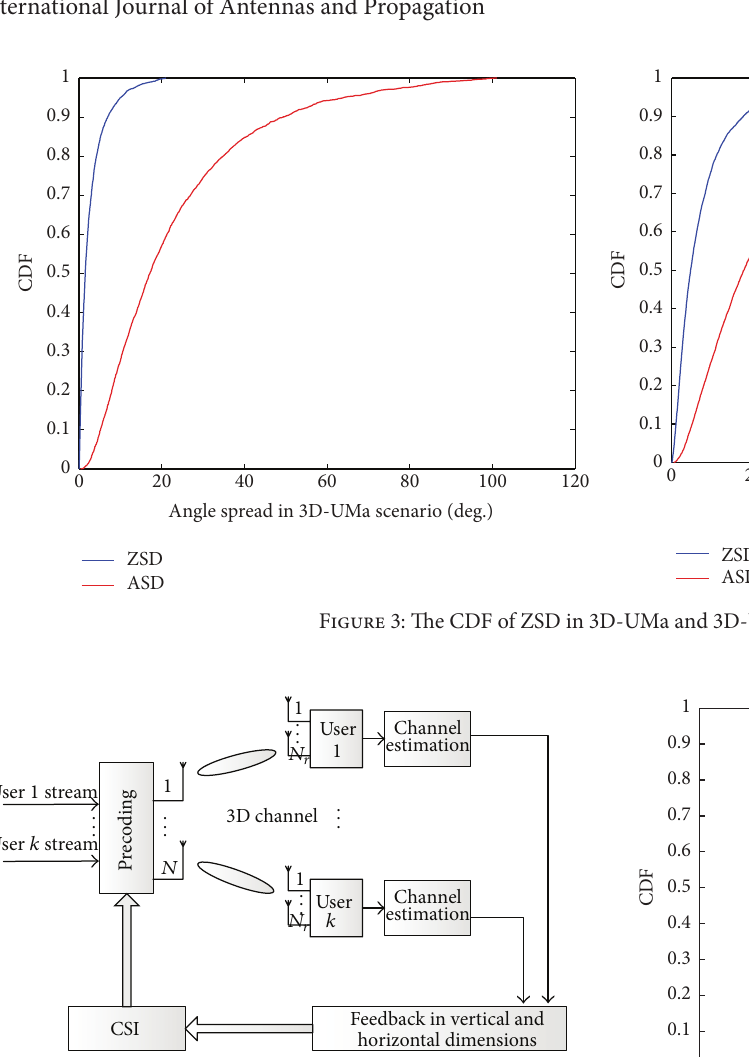
Figure 4: Limited feedback model of 3D MIMO.